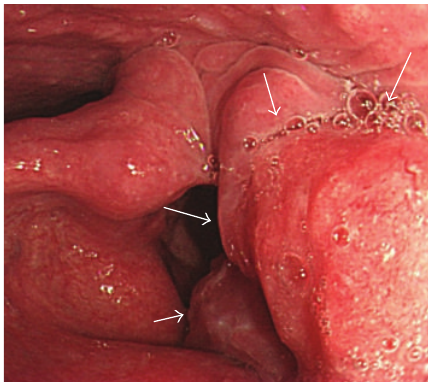
Figure 1: Preoperative findings of the larynx. The tumor was seen at the left arytenoid (arrow), and the left vocal cord was fixed.